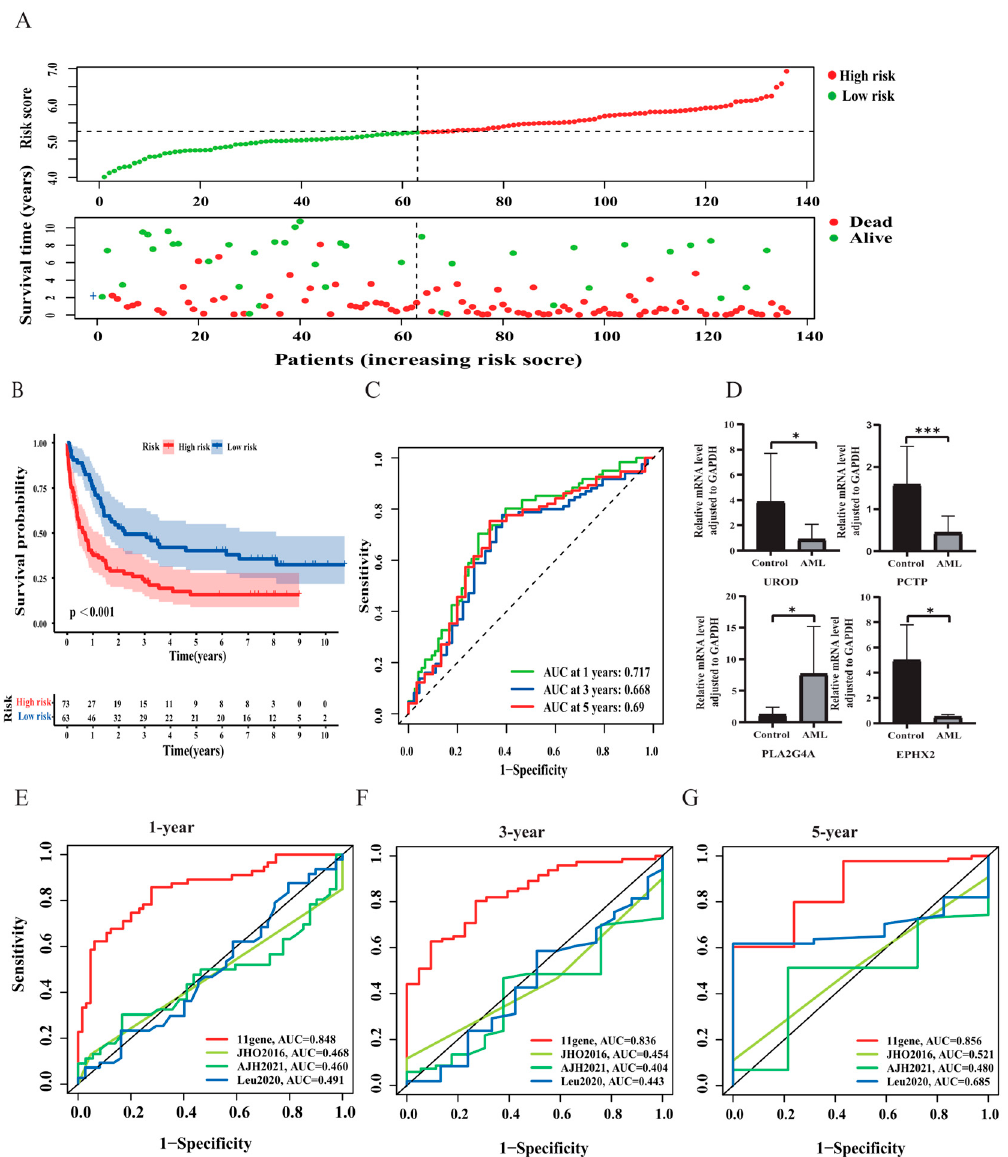
Figure 5. Validation of the risk signature. ( A , B ) Risk score distribution and survival status, Kaplan– Meier curve in the GEO cohort. ( C ) ROC curves for predicting survival at 1 year, 3 years, and 5 years in the GEO cohort. ( D ) Validation of the expression of UROD, PCTP, PLA2G4A, and EPHX2 in AML samples by qPCR. ( E – G ) AUC comparison between the risk signature based on 11 FAM-related genes and other previously published prognostic signatures. * p < 0.05 and *** p < 0.001.